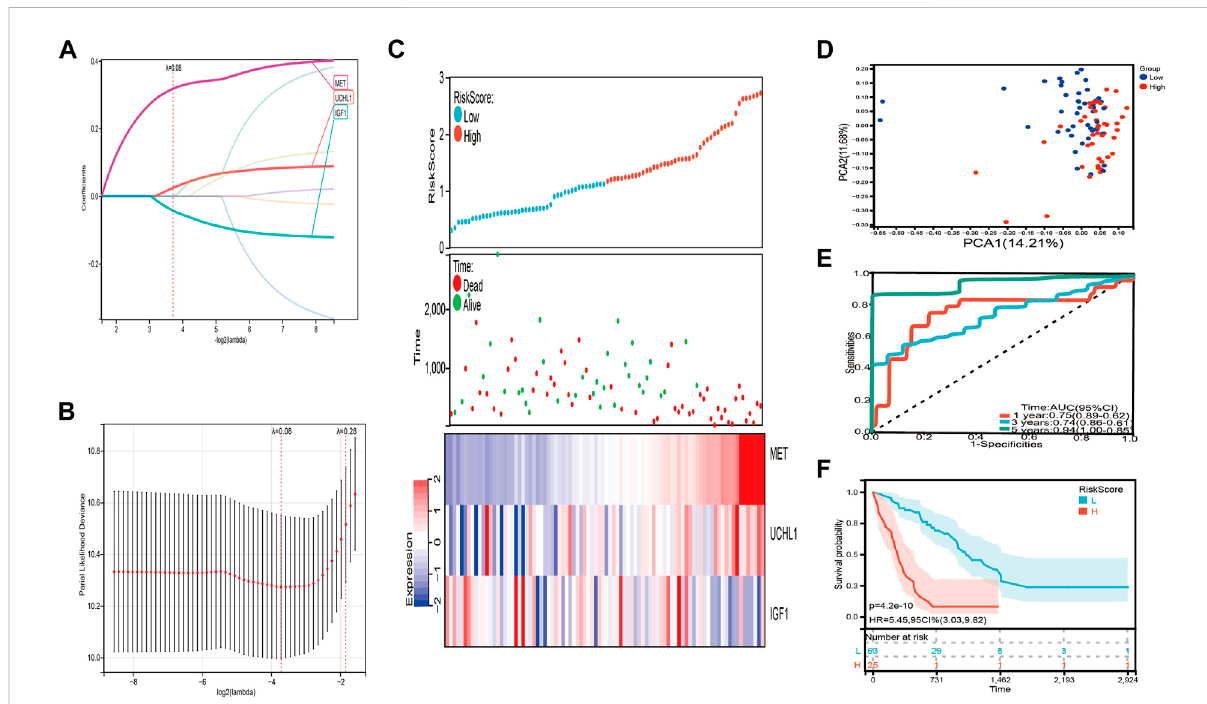
FIGURE 4 Constructionoftherisksignatureinthetrainingset. (A,B) Crossvalidationfortuningparameterselectionandlassoanalysisofeightdifferentially expressed prognostic genes related to COVID-19. (C) The distribution of risk score, survival status, and expression level of three differentially expressed prognostic genes related to COVID-19 between high-risk and low-risk group. (D) The PCA plot of the training set. (E) Time-dependent ROC analysis. (F) The overall survival of IPF patients in high-risk and low-risk